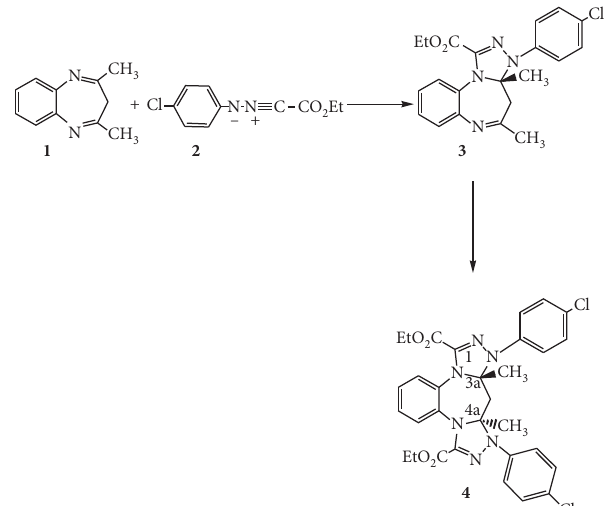
Scheme 1: Reaction of 2,4-dimethyl-3H-1,5-benzodiazepine 1 with N-aryl-C-ethoxycarbonylnitrilimine 2